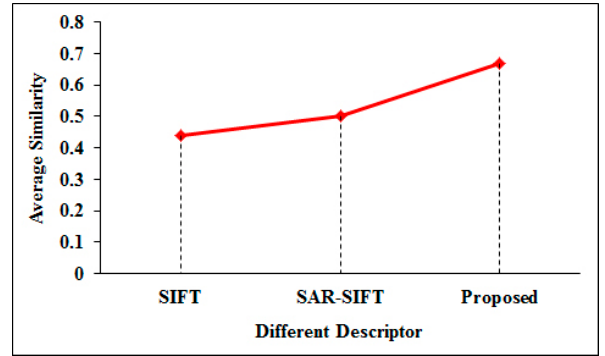
Figure 4. Descriptor evaluation.